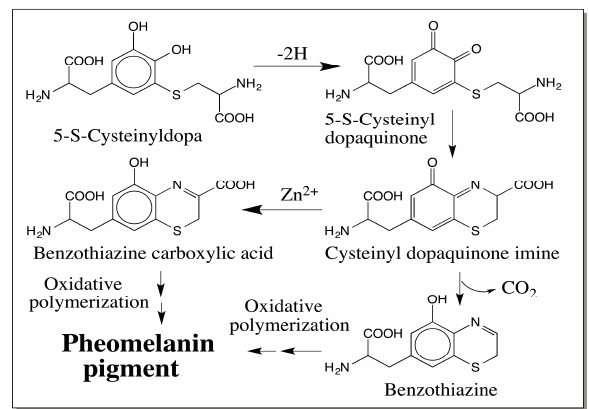
Figure 11. A simplified model for the biosynthesis of pheomelanin. Using the major product—5- S -cysteinyldopa—as the precursor, the biosynthesis of pheomelanin is illustrated in this figure. Oxidation of 5- S -cysteinyldopa produces its quinone, which undergoes internal condensation reaction producing the quinone imine. Quinone imine either rearranges to form benzothiazine-3-carboxylic acid or undergoes decarboxylation to benzothiazine. Oxidative polymerization of these two compounds produces the majority of the red to brown pheomelanin pigment in all animals .